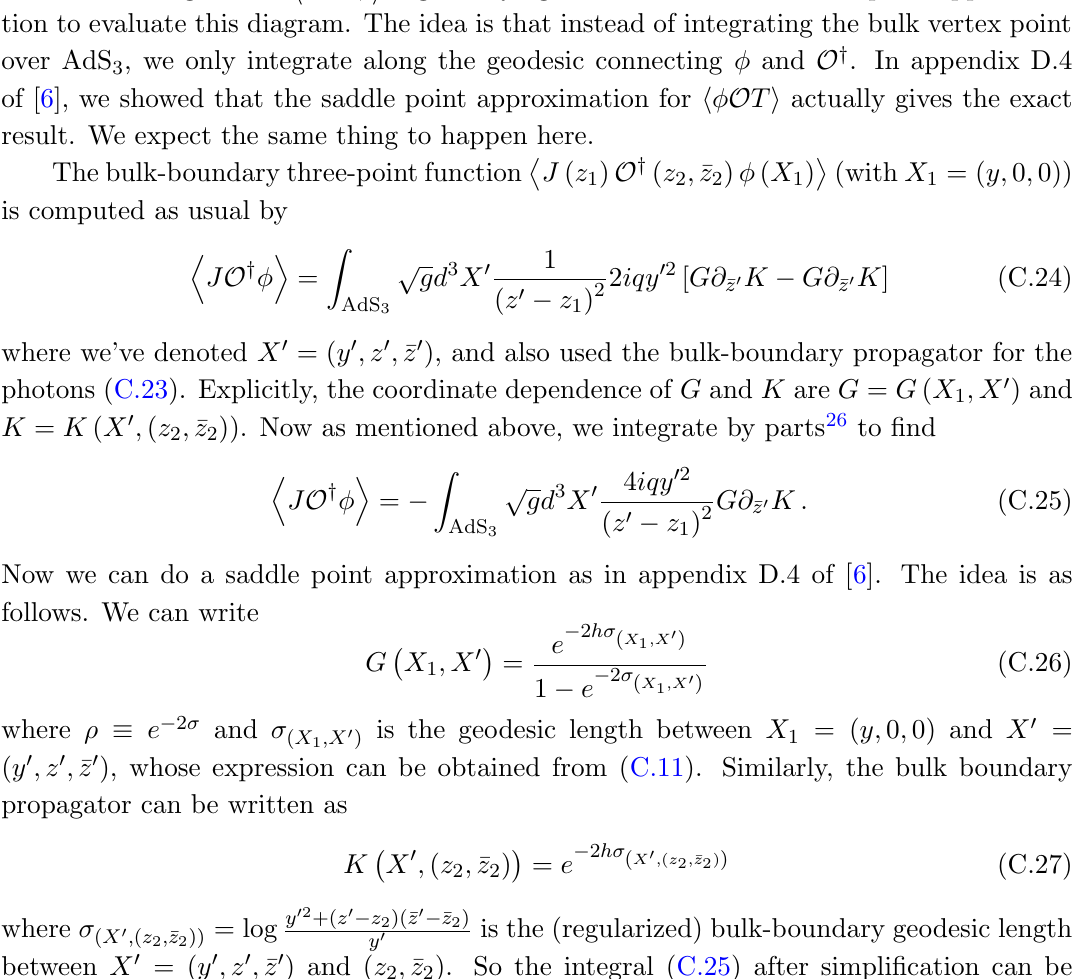
J (cid:30) h O y i